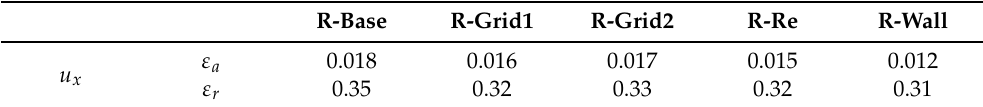
u i / U ref . The tangential (cid:104) (cid:105) s